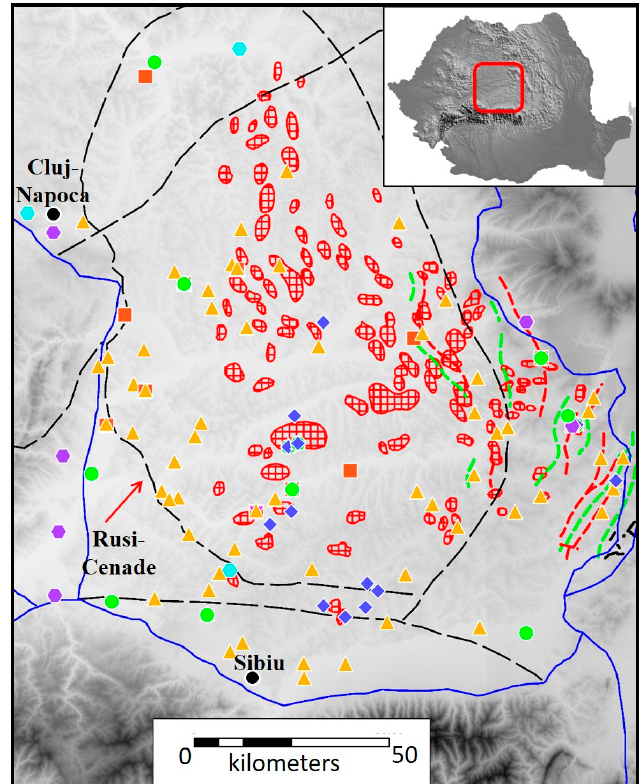
Figure 5. Distribution of uncertain seeps in relation to major faults (blue dashed lines). Tectonics after [48,49,54].